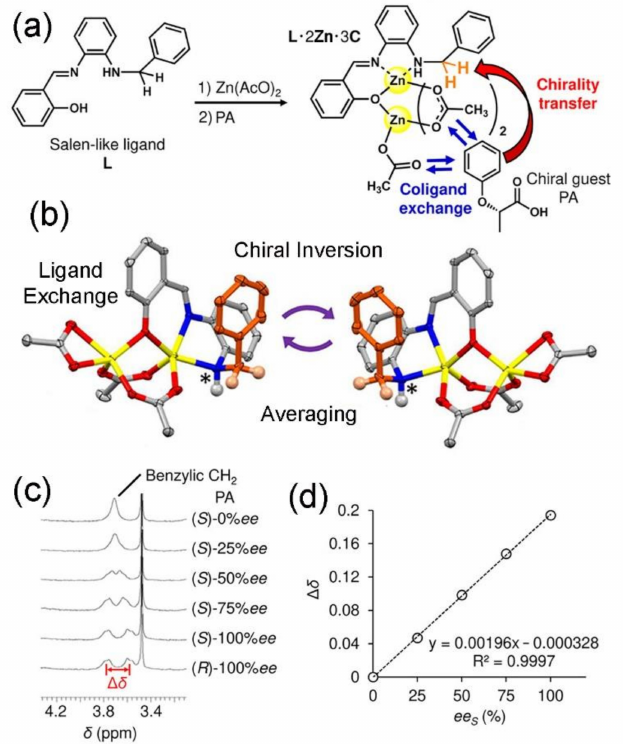
Figure 9. ( a ) Mechanism of chirality transfer in a mixture containing the species L , Zn ( AcO ) 2 and PA . ( b ) Benzylic CH 2 resonance in the 1 H-NMR spectra (in CDCl 3 , 25 ◦ C) of L · 2 Zn · 3 C in the presence of PA at different ee . ( c ) The magnitude of splitting ( ∆ δ ; from (b)) depends linearly on ee of PA . ( d ) X-ray crystal structure of L · 2 Zn · 3 AcO showing possible sources of signal averaging in NMR spectra, including chiral inversion (at amine atom) and ligand exchange. Adapted with permission from Ref. [47]. Copyright 2020 American Chemical